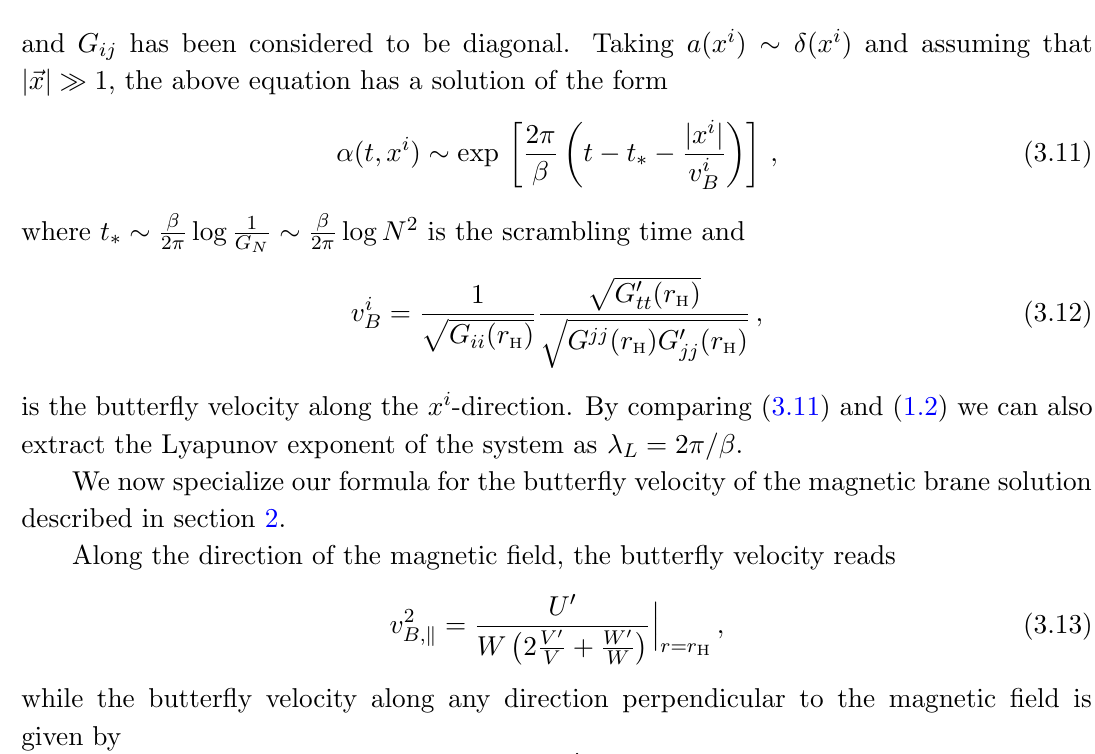
Figure 2 . Penrose diagram for the shock wave geometry. This geometry is dual to a thermo(cid:12)eld double state perturbed at a time t 0 in the far